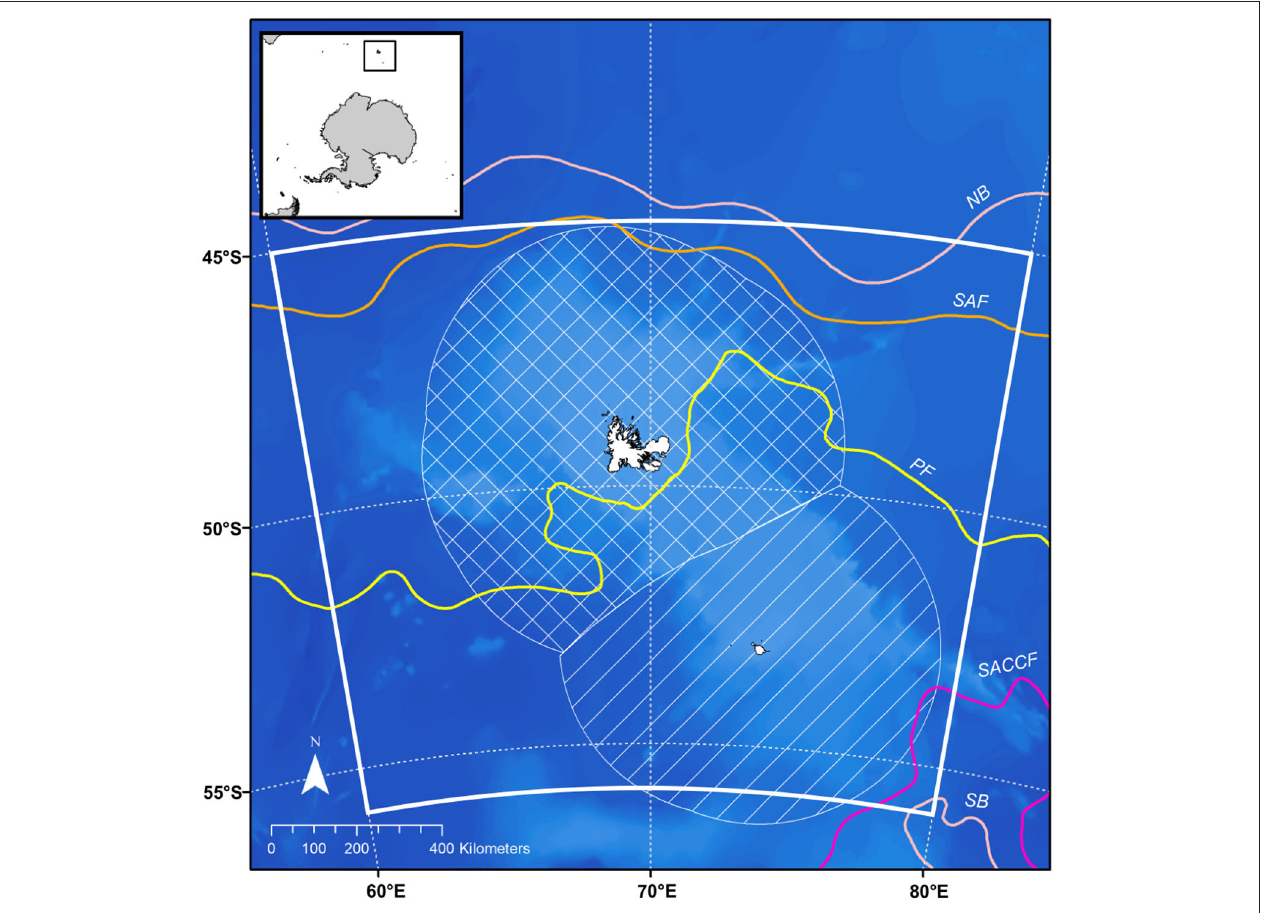
FIGURE 1 | Map of the Kerguelen Plateau, model domain (60 ◦ –80 ◦ E, 45 ◦ –56 ◦ S) is indicated by the white box, the hatched area indicates the French EEZ, striped area indicates the Australian EEZ. Front positions and boundaries of the Antarctic Circumpolar Current (ACC) as described in Park et al. (2014), bathymetry data are from https://www.gebco.net. NB, northern boundary of the ACC; SAF, subantarctic front; PF, polar front; SACCF, southern ACC front; SB, southern boundary of the